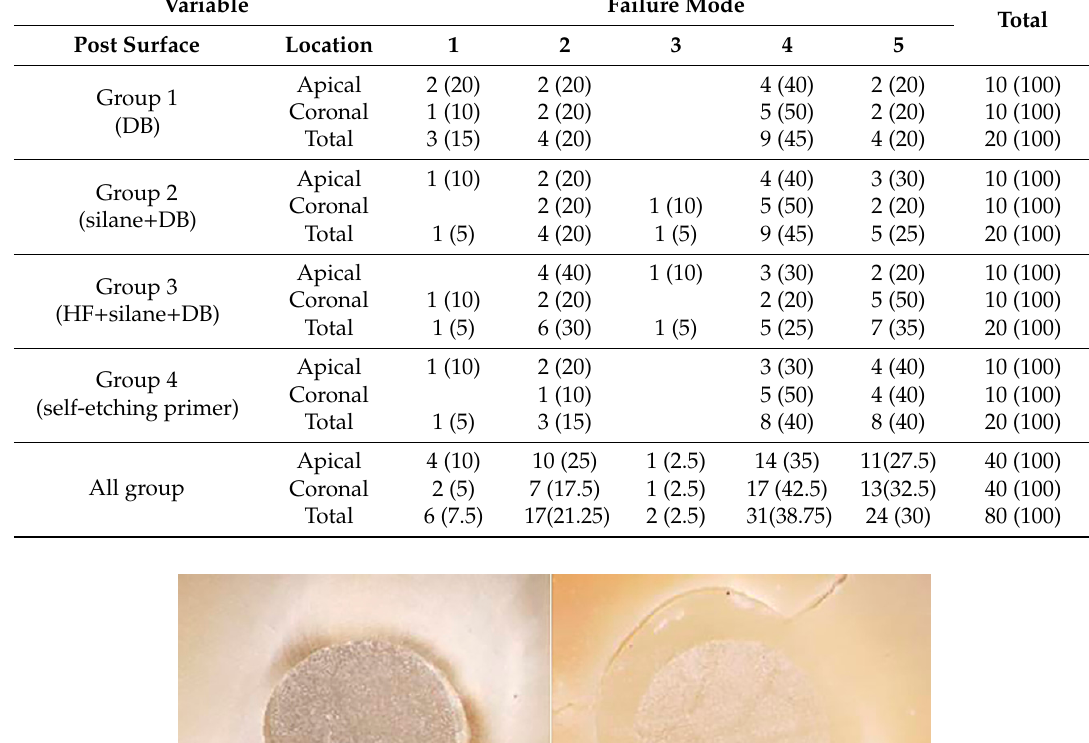
Table 4. Distribution of failure modes according to the experimental groups (%).